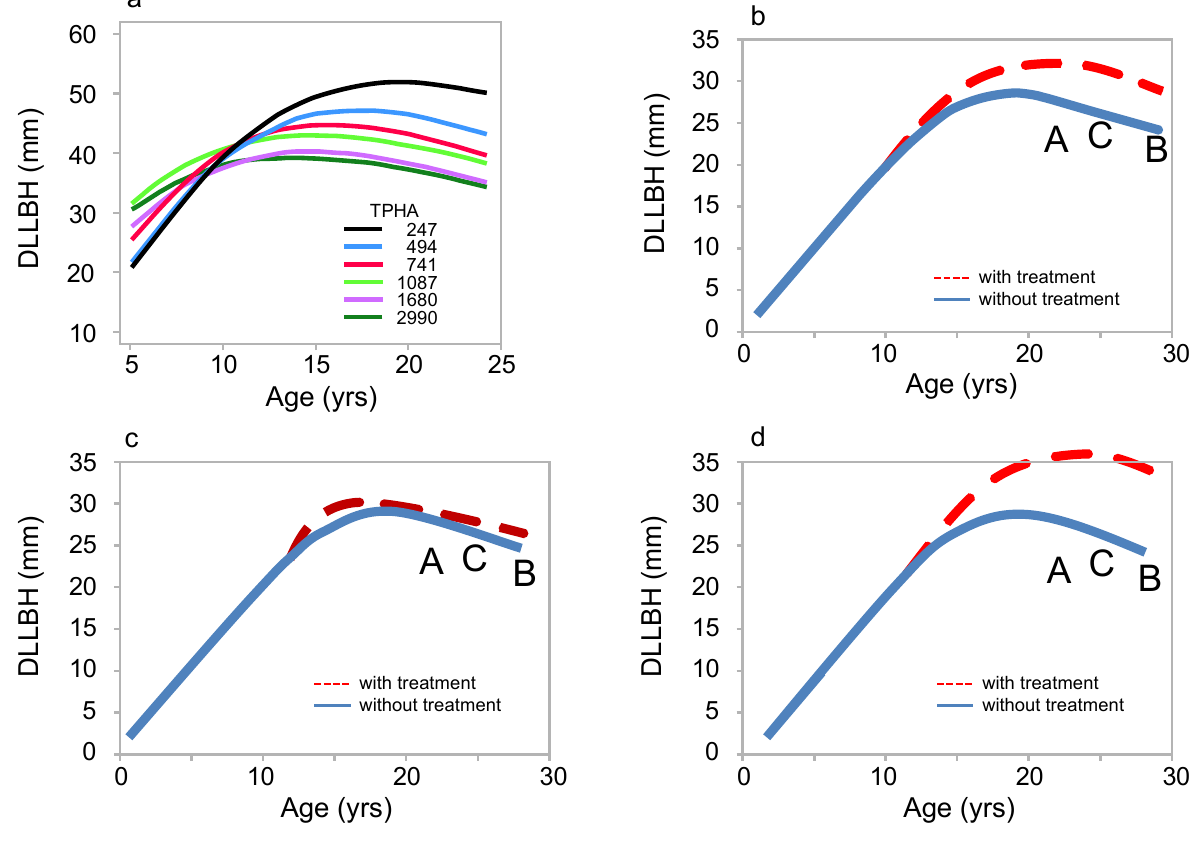
Figure 6. Hypothesized effects of ( a ) initial planting density (adapted from [23]) ( b ) thinning, ( c ) fertilization, and ( d ) thinning plus fertilization on branch diameter measured over time on the stem surface; in b-d dashed lines represent change in live branch diameter due to treatment; if treatment began when point A of a dead branch was at the stem surface, branch diameter would decrease to B; however, if no treatment occurred, branch diameter at the stem surface would only decrease to C due to slower dbh increment in absence of